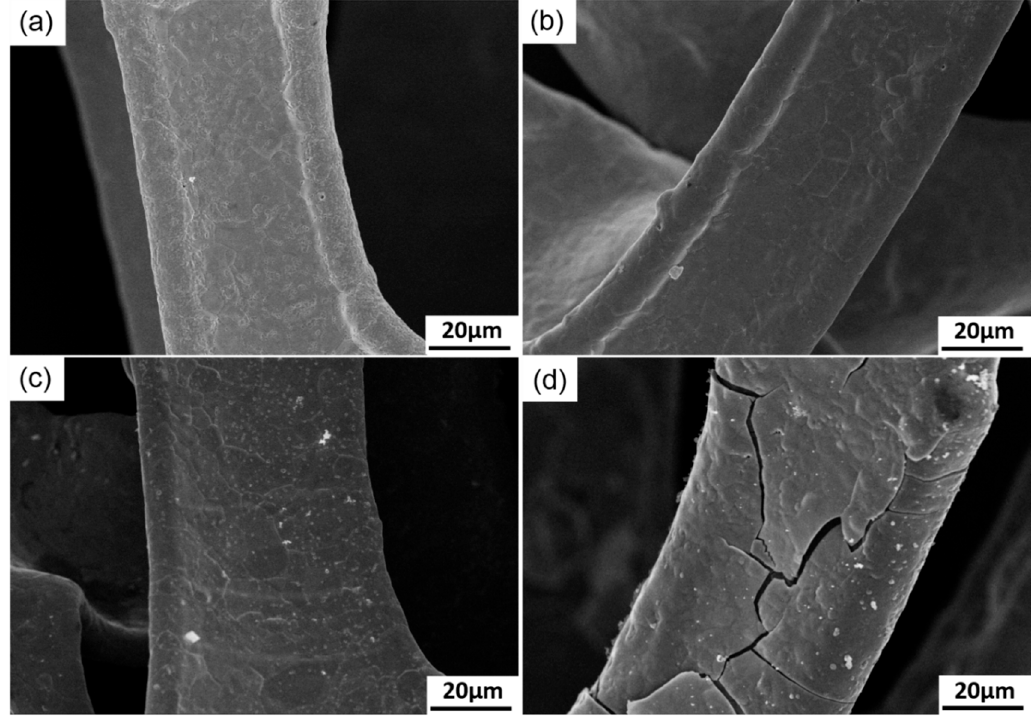
Figure 15. Surface morphologies of MnO 2 deposited on nickel foam. ( a ) 60 s; ( b ) 120 s; ( c ) 300 s; ( d ) 600